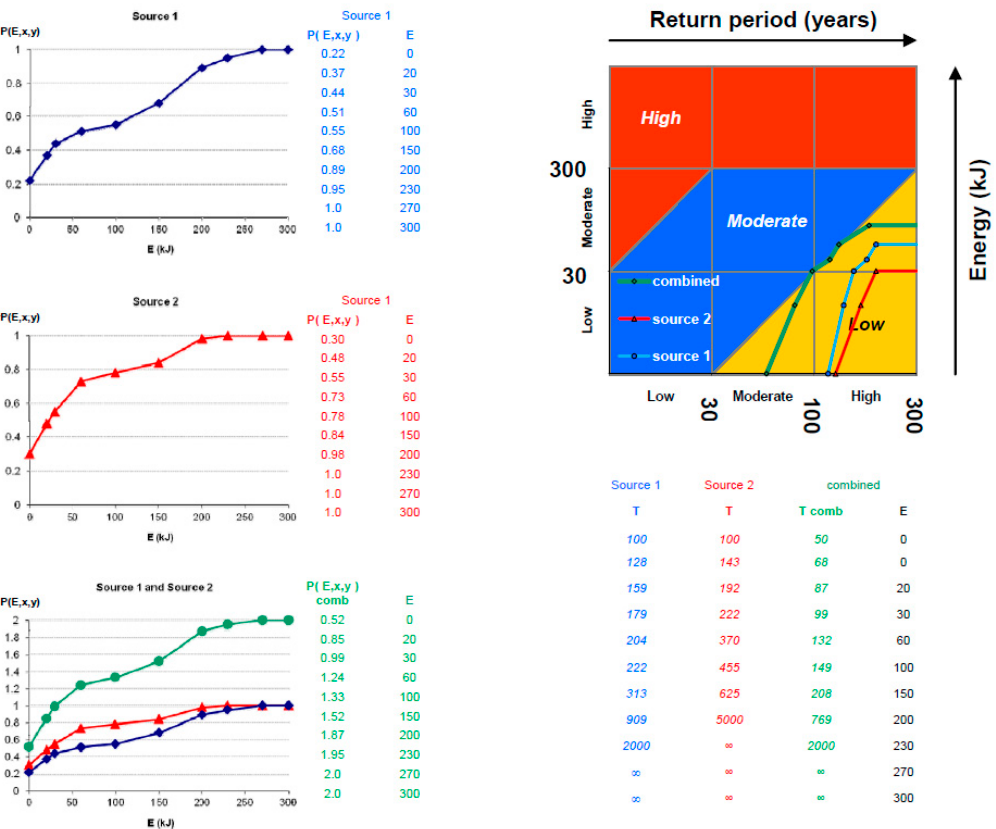
Figure 3. Example of combination of 2 rock fall hazards at a given cell of the slope (same failure frequency λ f, 1 D = 1 / 50 (years · m) − 1 and block volume d = 0.5 m considered).